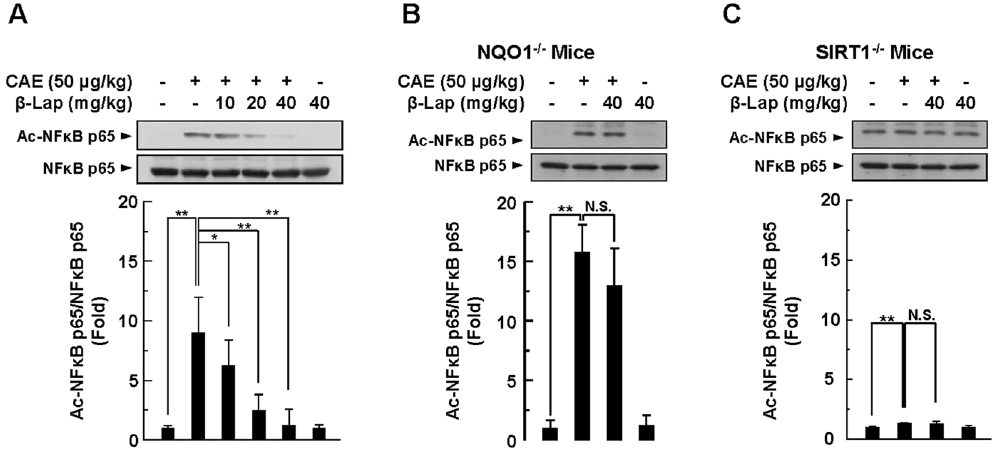
Figure 7. β -Lap attenuates caerulein-induced acetylation of NF- κ B p65. Acetylated NF- κ B p65 and total NF- κ B p65 levels were determined by western blotting using anti-acetylated NF- κ B p65 (K310) and anti-NF- κ B p65 antibodies in the pancreatic tissues of WT ( A ), NQO1 − / − ( B ), and SIRT1 − / − mice ( C ). Each value represents the mean ± SD ( n = 3). * P < 0.05, ** P <